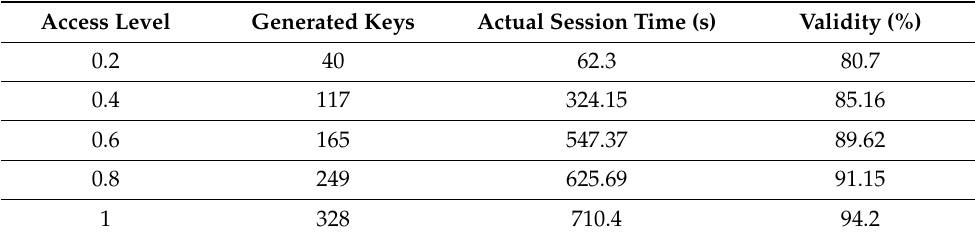
Table 3. Session validity (%) for different access